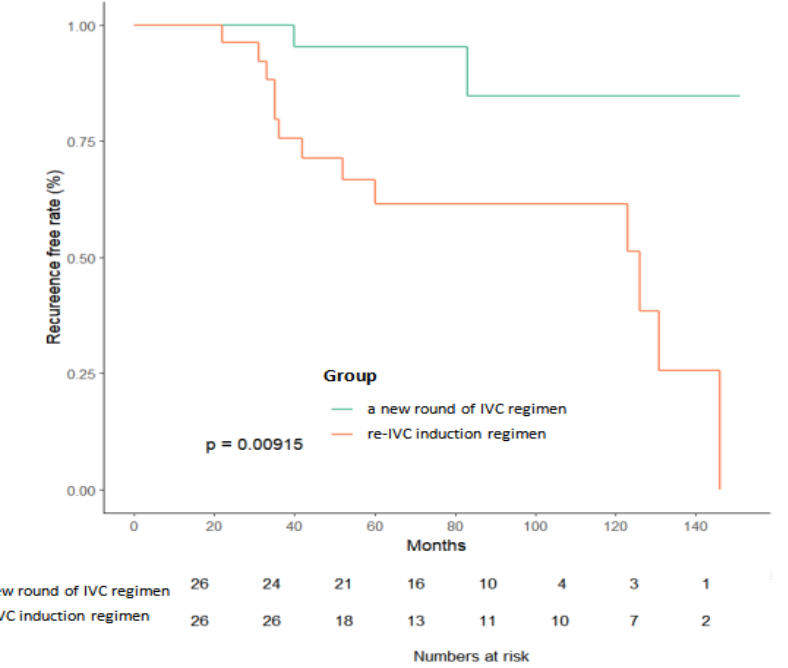
Figure 3. Non-recurrence curve after TURBT in two groups. Non-recurrence rate of the new round group was significantly higher than that of the original group ( p = 0.0292) in patients who presented with a residual tumor.